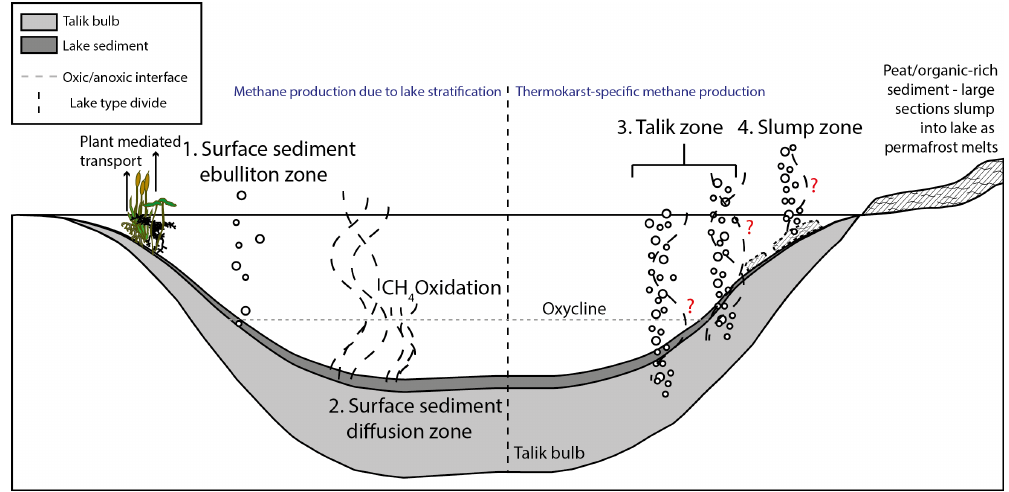
Figure 1. Illustration of methane production zones and emission pathways in lakes alongside thermokarst-specific zones and pathways. (1) Surface sediment ebullition zone (background methane production). Methane that is produced in the anoxic surface sediments is released via ebullition, usually near the margins (Bastviken et al., 2004). (2) Surface sediment diffusion zone. Methane is produced in the anoxic surface sediments and diffuses in the sediments above and into the water column. Some of this methane will reach the water surface–air interface, but a large amount is likely to be oxidised by MOB (Kankaala et al., 2006). This process is common in many lakes also. (3) Talik zone. Methane is produced in the deeper talik sediments underneath the lake and is released via ebullition seeps (Walter et al., 2007a). Often this is a higher flux and is more constant than surface sediment ebullition. This production zone and pathway is a thermokarst-specific process. (4) Slump zone. Methane production in the surface sediments is increased due to the introduction of large volumes of slumped sediments. This methane is also released via ebullition seeps. Often, the flux from these ebullition seeps is higher than surface sediment ebullition but not as high as talik ebullition. This process might occur in any lakes that have dynamic margins and high erosion rates; however, it is likely that this process is most common in thermokarst lakes due to the melting of permafrost, so it is termed thermokarst-specific. Red question marks indicate where methane diffusion from the sediments has not been studied in